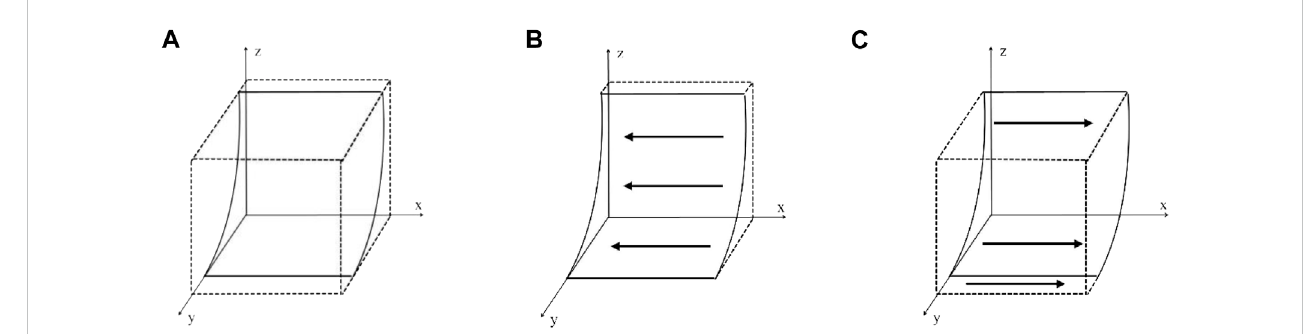
FIGURE 2 Dynamic evolution phase diagrams of